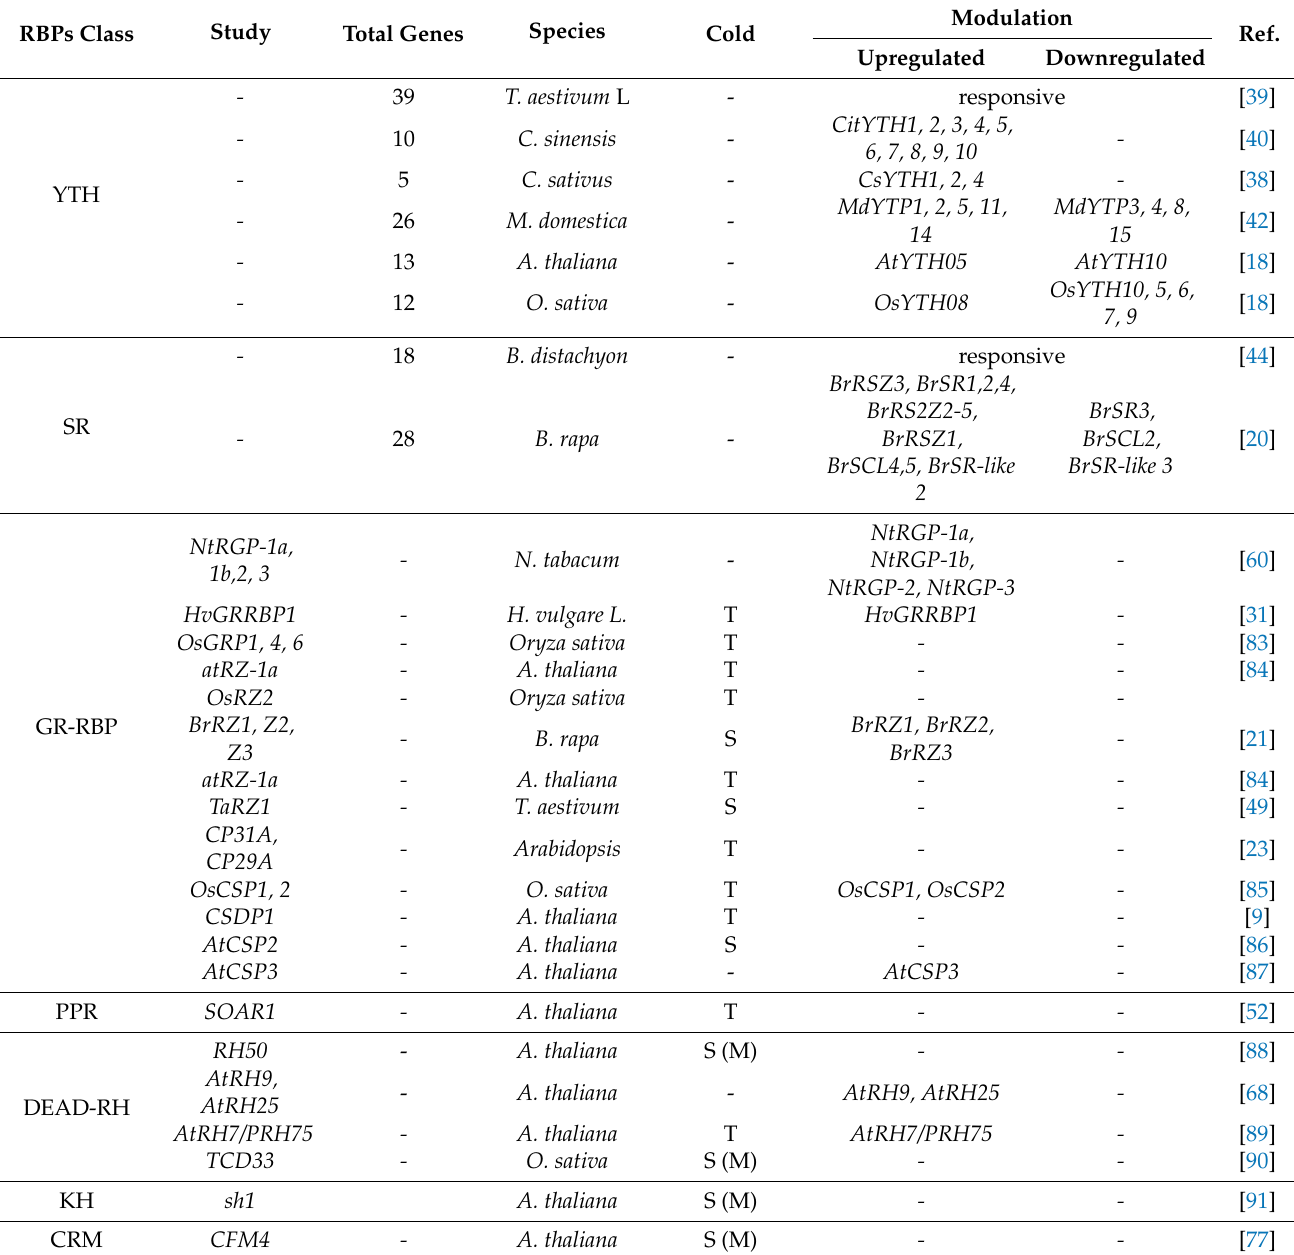
Table 4. Plant RNA binding proteins implicated in cold/low-temperature stress